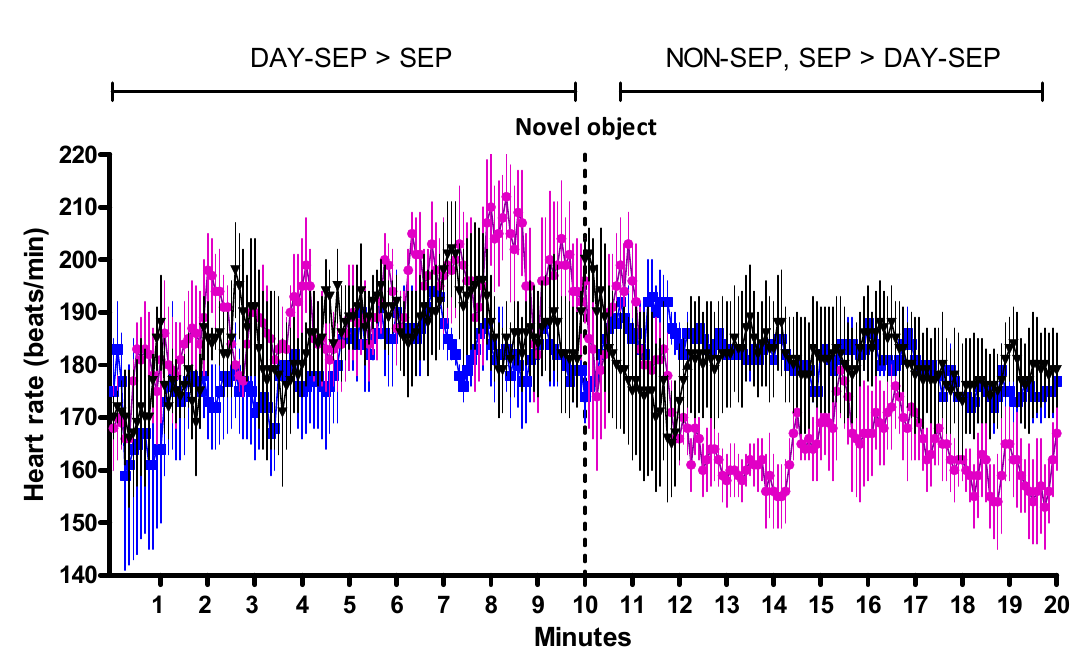
Figure 2. Saliva cortisol concentrations in nmol/L, (means ± SEM) in SEP kids ( ) DAY-SEP kids ( ) and NON-